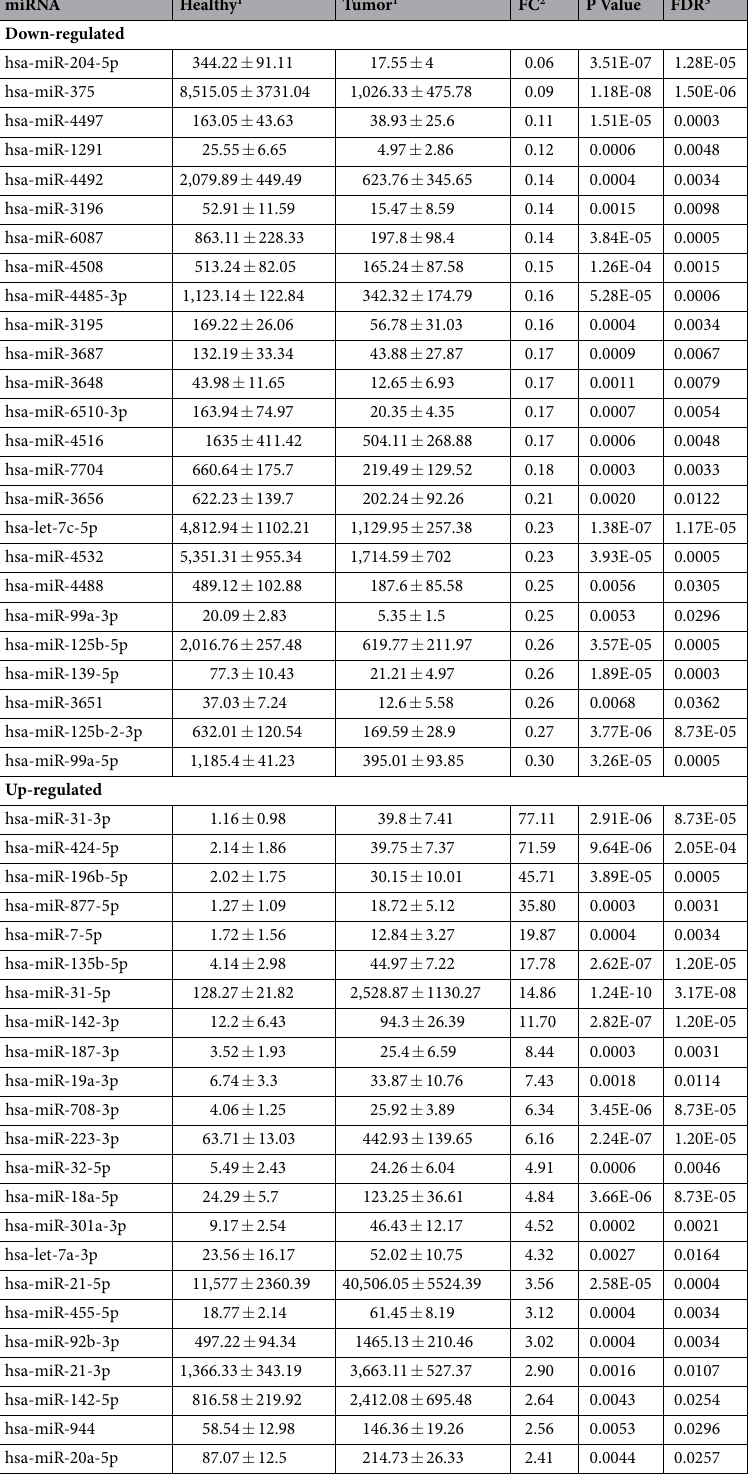
Table 1. MicroRNAs differentially expressed between tumor and healthy adjacent tissue in patients diagnosed with HNSCC. 1 miRNAs are expressed as reads per million (rpm). miRNA with less than 3 rpm in less than 50% of the samples were removed from analysis. 2 Fold change in Tumor compared to Healthy tissue. 3 False discovery rate. Only miRNAs with FDR lower than 0.05 were considered as significantly